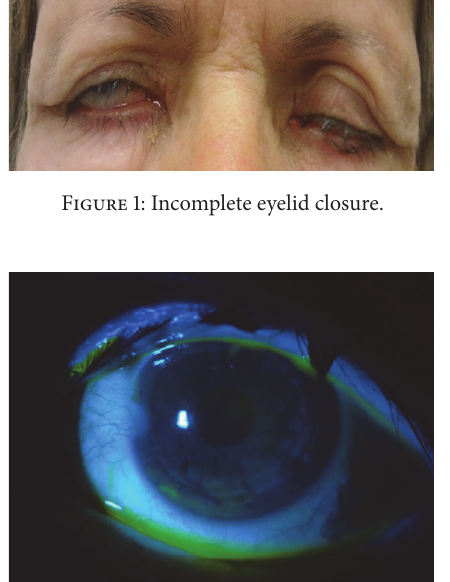
Figure 4: Corneal opacification with